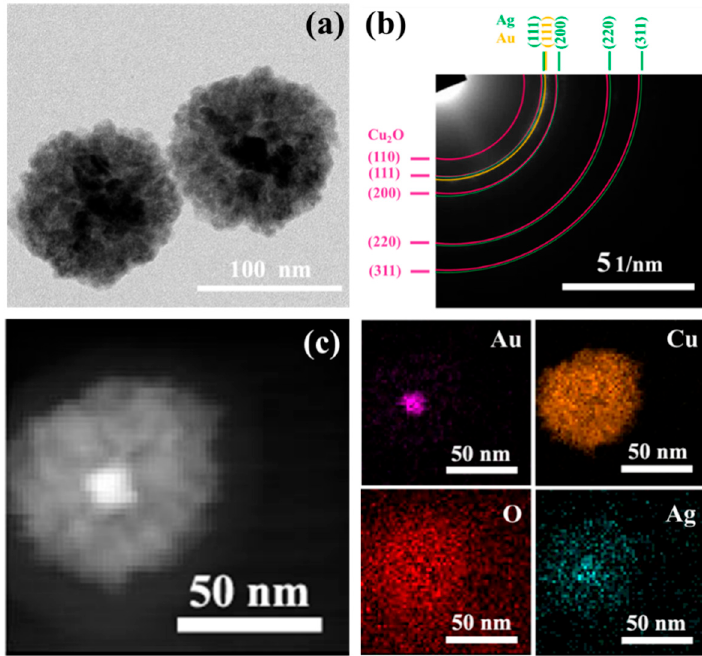
Figure 7. TEM image ( a ), SEAD pattern ( b ), HAADF-STEM image ( c ) of AC-1-Ag NCs with corresponding EDS elemental mapping images (Au, Cu, O, and Ag).